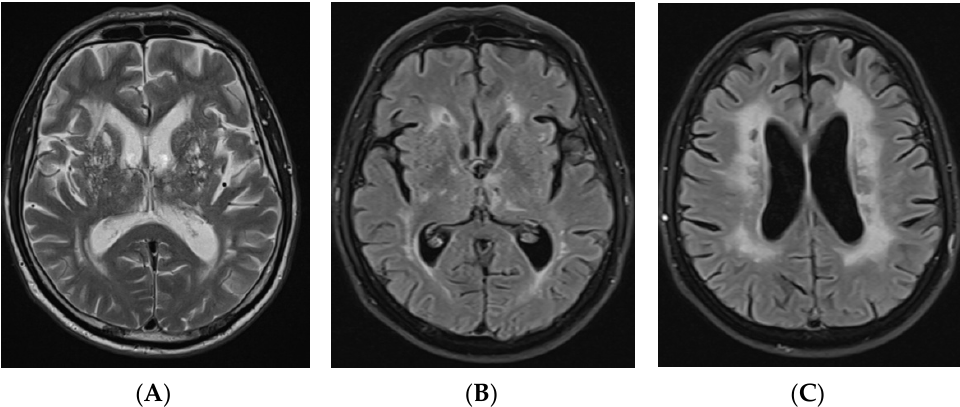
Figure 1. Axial T2-weighted image ( A ) and FLAIR axial images ( B , C ) of brain MRI demonstrating subcortical and periventricular T2/T2 dark-fluid hyperintensities, Fazekas scale score 2–3, lacunar lesions in the thalamus bilaterally, and hydrocephalus (HI—66). FLAIR: fluid attenuated inversion recovery; MRI: magnetic resonance imaging, HI: Huckman index.